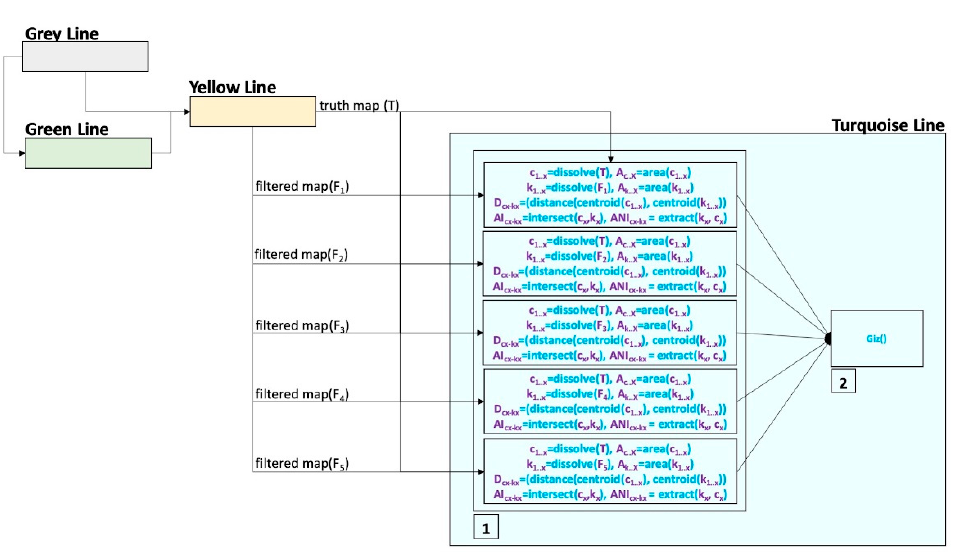
Figure 6. The turquoise line for similarity calculation with Giz Index.